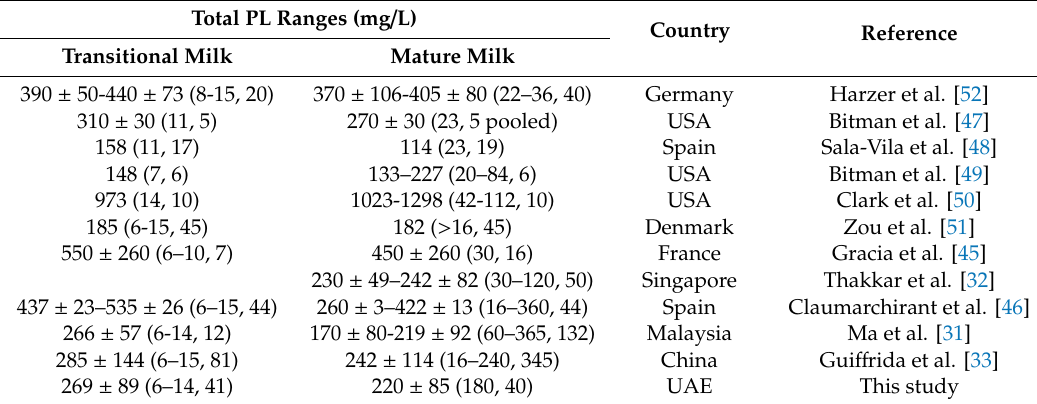
Table 4. Human milk phospholipid concentration reported in the literature for both transitional and mature milk (modified from Ma et al. [31]) a